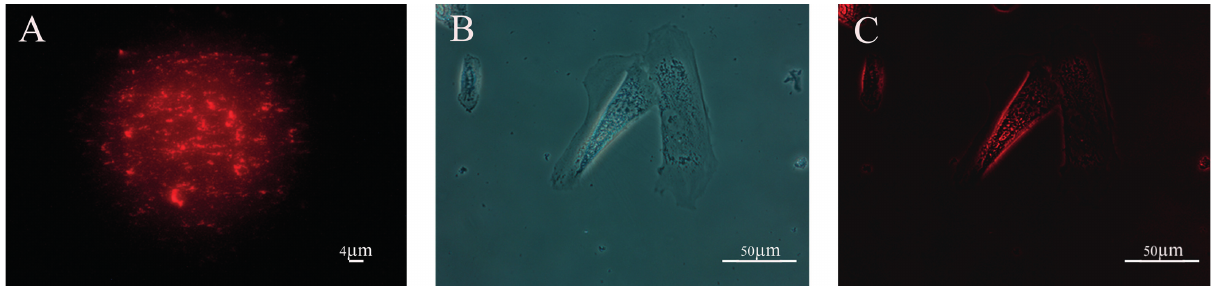
Fig. 1. Images of QDs and OD-labeled hAM-dMSCs. Using the single 570 nm wavelength of light of the fluorescence microscope, QDs (A) and QDs (1.5 μg/mL, B before fluorescence microscope, C after fluorescence microscope ) taken by hAM-dMSCs at